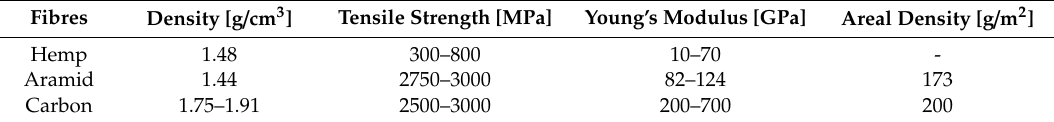
Figure 1. Types and forms of fibres used in laminates: ( a ) short hemp fibres, ( b ) aramid fabric, ( c ) carbon fabric. Table 1. Physical and mechanical properties of fibres.